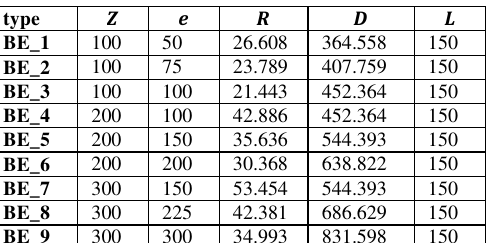
Fig. 12. ERCOP piston motion curves Table 7. Geometrical engine parameters for